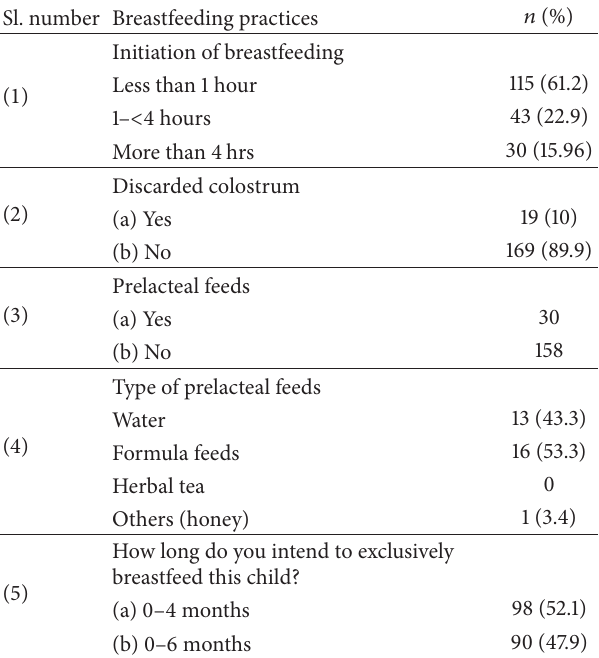
Table 1: Sociodemographic characteristics (total 𝑛 = 188 ). Characteristics